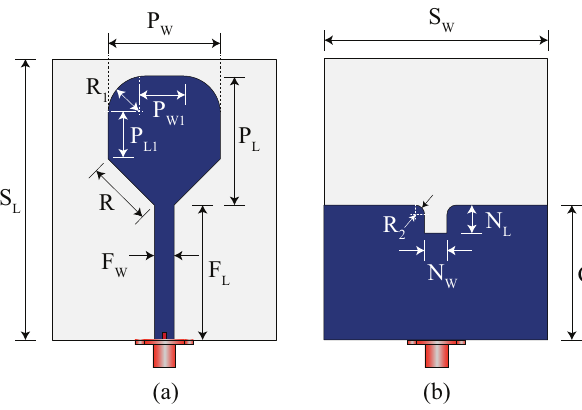
FIGURE 3: Proposed miniaturized single element: (a) Top- view. (b) Back-view. TABLE 1: Detailed dimensions of proposed single